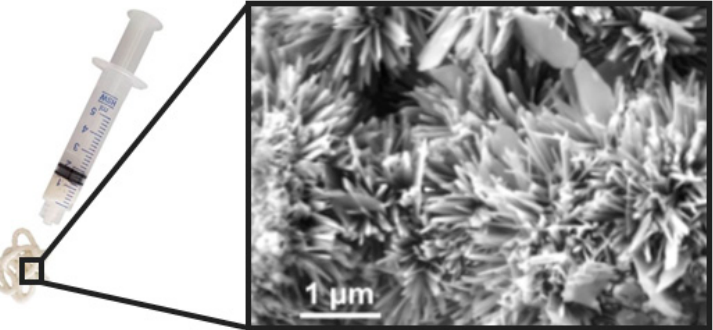
Figure 4. Biomimetic injectable bone cements ( left ) and SEM micrograph showing the typical needle and plate-like morphology ( right ).